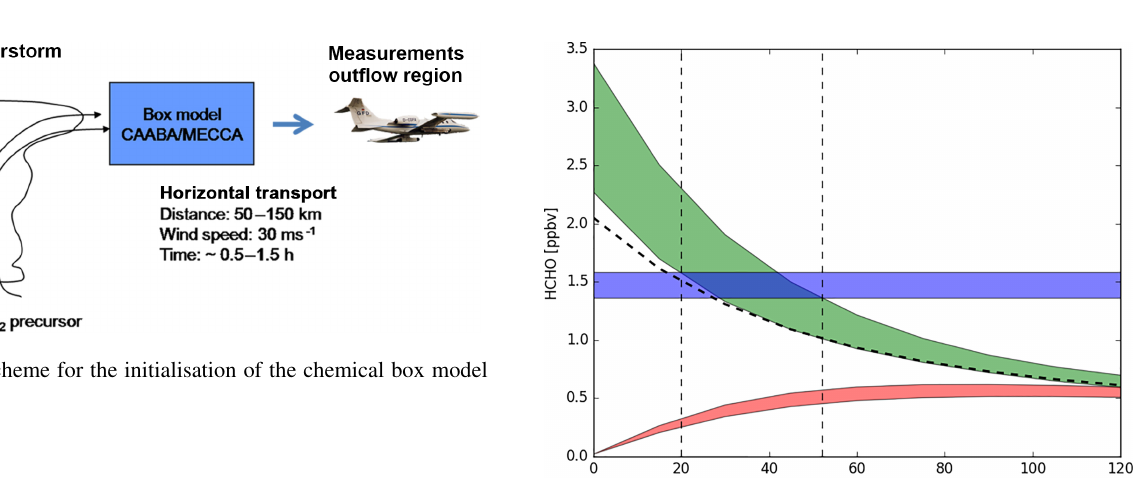
Figure 7. Vertical profiles from in situ measurements on 19 July 2007. Colour coding indicates altitude (see upper panel). The grey shaded area shows typical mixing ratios in the upper troposphere.